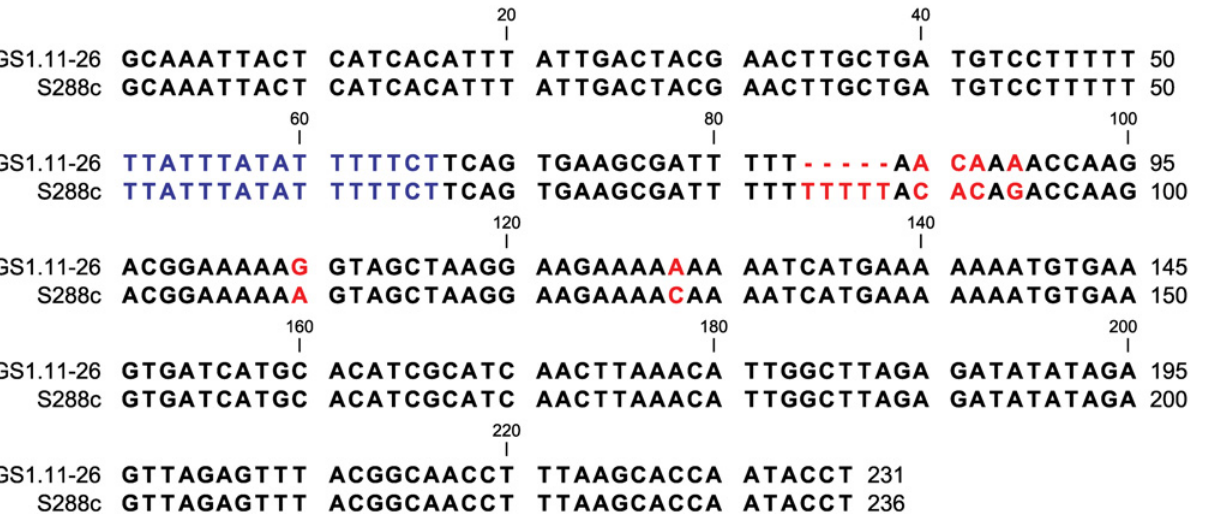
Fig 8. ARS1529 sequence comparison between the evolved strain GS1.11 – 26 and the sequence in the reference strain S288c. The nucleotide sequence in blue represents the ARS consensus sequence [24]. A gap of 5 base pairs in GS1.11 – 26 from bp 84 till 88 is indicated with red dashed lines. Other SNPs are also shown in red. The sequence from GS1.11 – 26 was confirmed by Sanger sequencing and was similar to the sequence obtained by Illumina